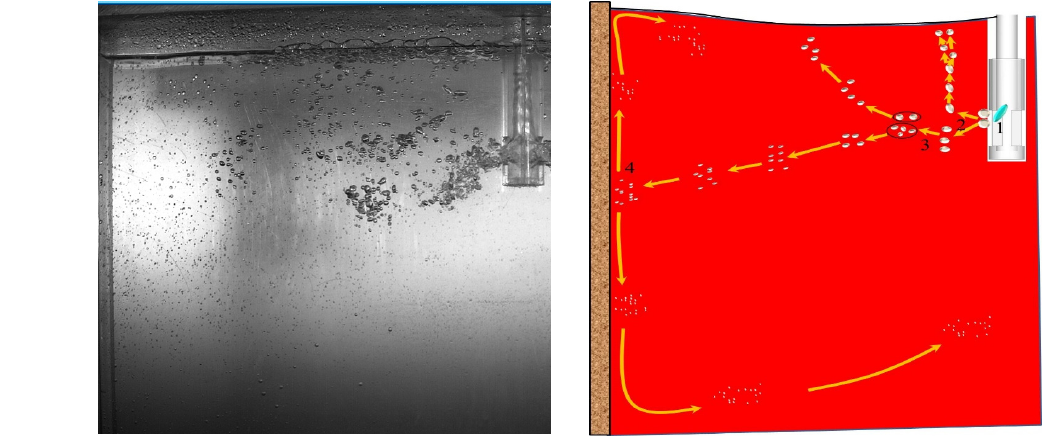
Figure 11. Bubble movement distribution.